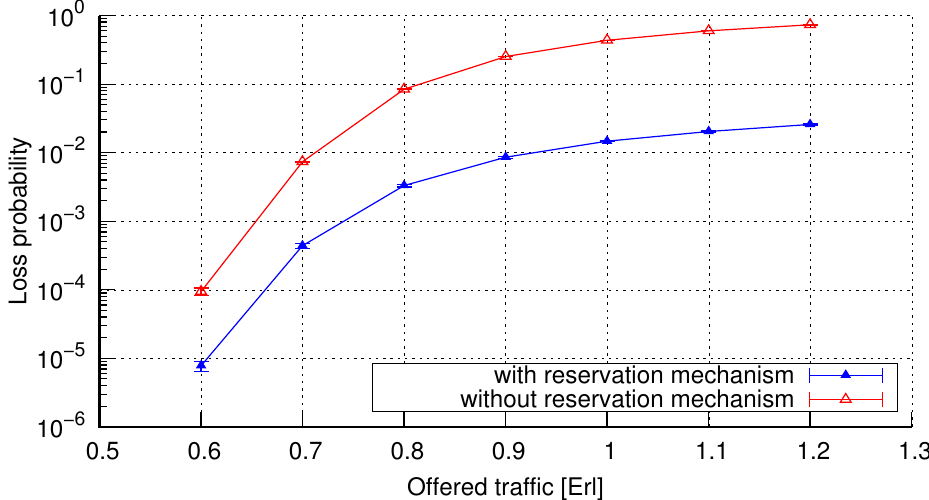
Figure 10. Loss probability for calls of class 3 (privileged class) in System 1.